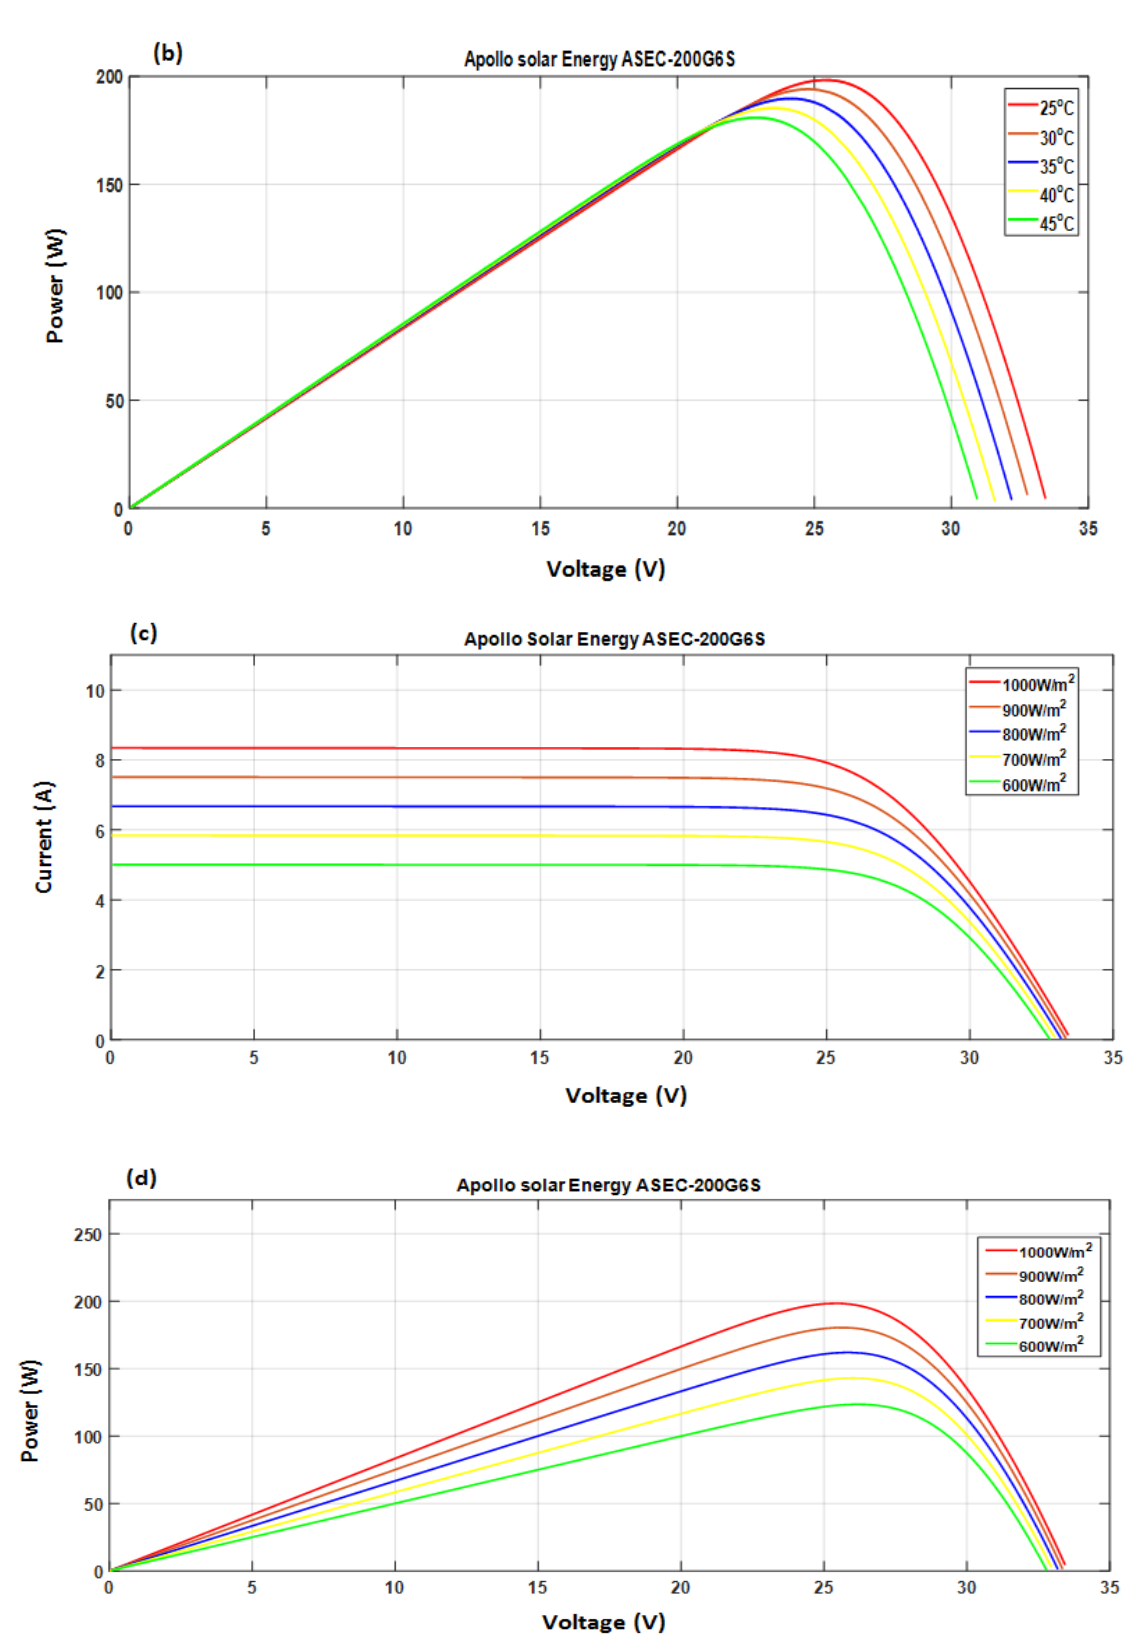
Figure 7. Influence of the variation in the temperature value on ( a ) characteristic I ‐ V; ( b ) charac ‐ P-V. Influence of variation in the irradiance value on ( c ) characteristic I-V; ( d ) characteristic teristic P ‐ V. Influence of variation in the irradiance value on ( c ) characteristic I ‐ V; ( d ) characteristic P ‐ V.